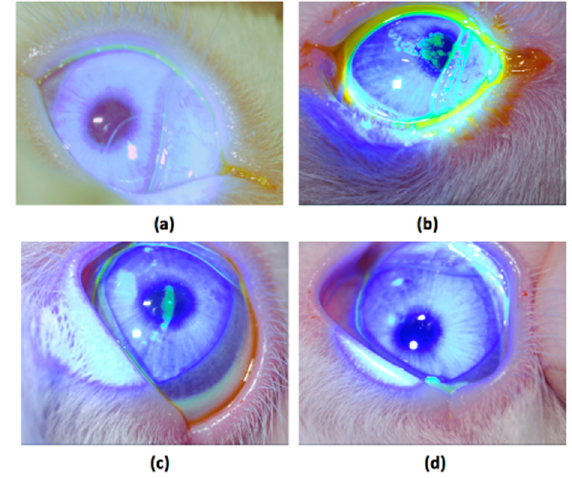
Figure 6. Slit lamp photographs of rabbit eyes after fluorescein (FL) staining. ( a ) Normal, ( b ) 0.1% benzalkonium chloride (BAC), ( c ) BS, and ( d ) BS plus FA100/KM1 treated groups. Damaged epithelial cells in the eyes were observed as green patches.